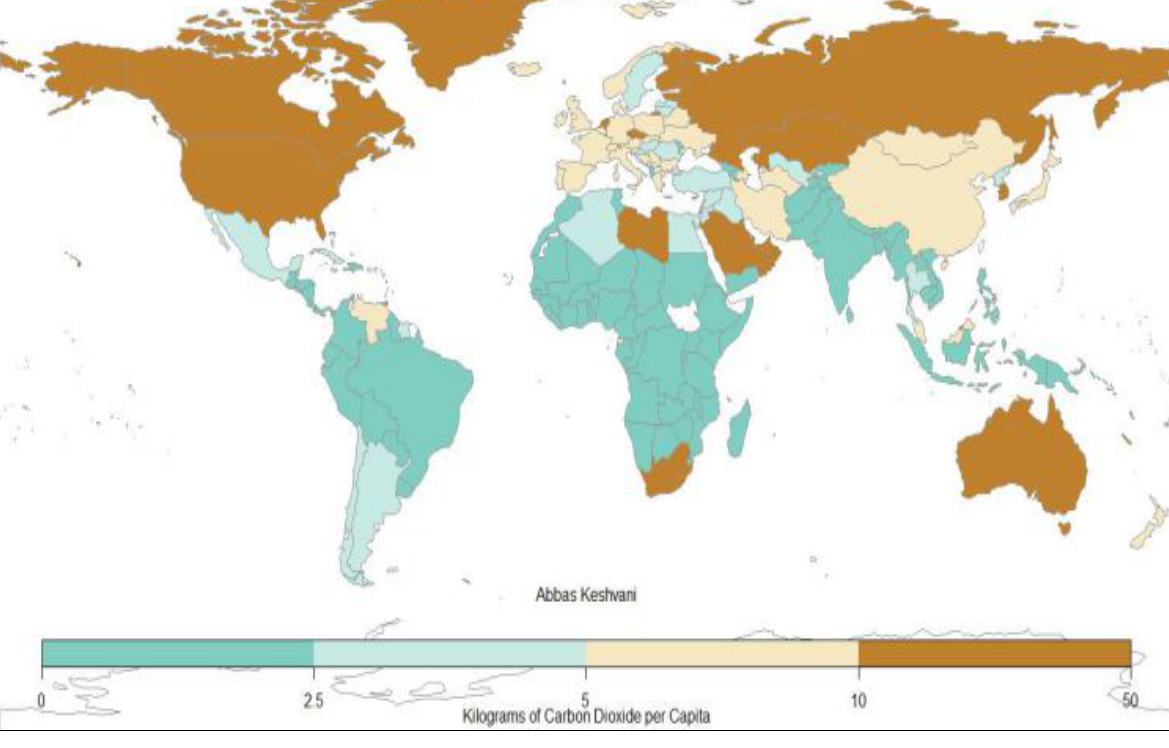
Source: Keshvani